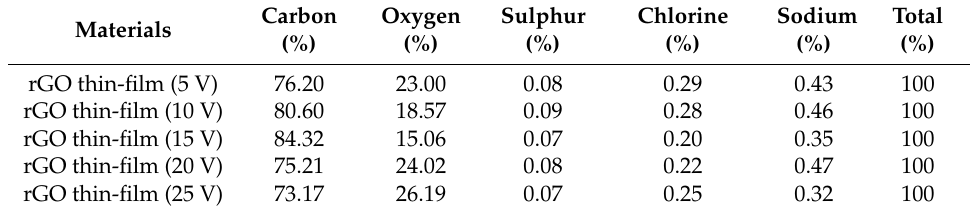
Figure 5. AFM topology of ( a ) 2D height, ( b ) 3D height, and ( c ) line profile of 15 V rGO thin film sample. Table 1. Energy-dispersive X-ray spectroscopy (EDX) analysis of elements present in reduced graphene oxide (rGO) thin films prepared at 5, 10, 15, 20, and 25 V by electrochemical reduction for 5 min.